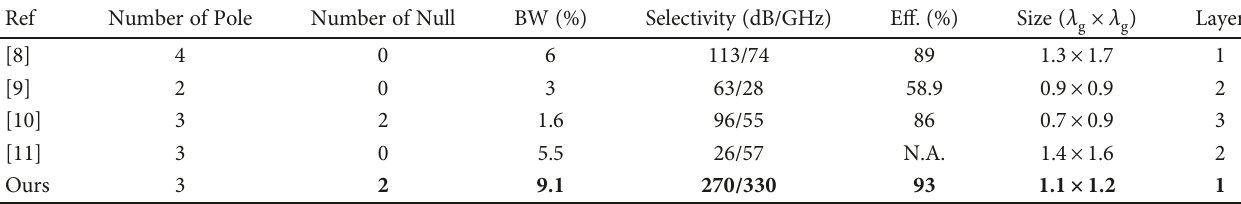
Table 1: Comparisons with previous reported